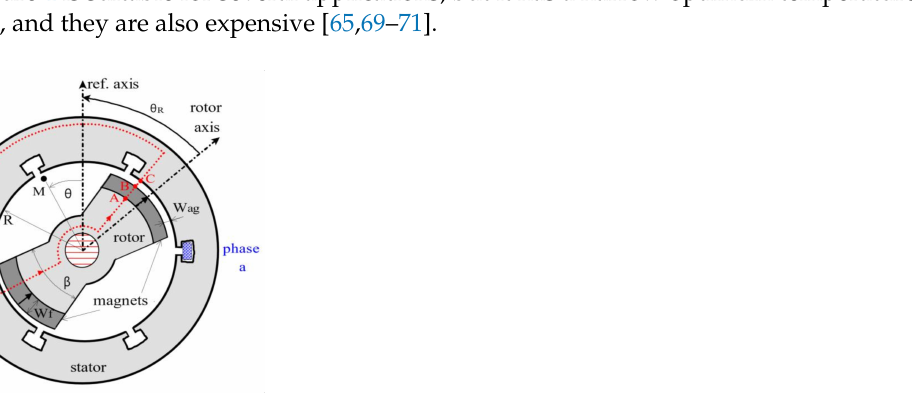
Figure 4. Diagram of permanent magnet synchronous machine (PMSM) for flywheels, adapted from